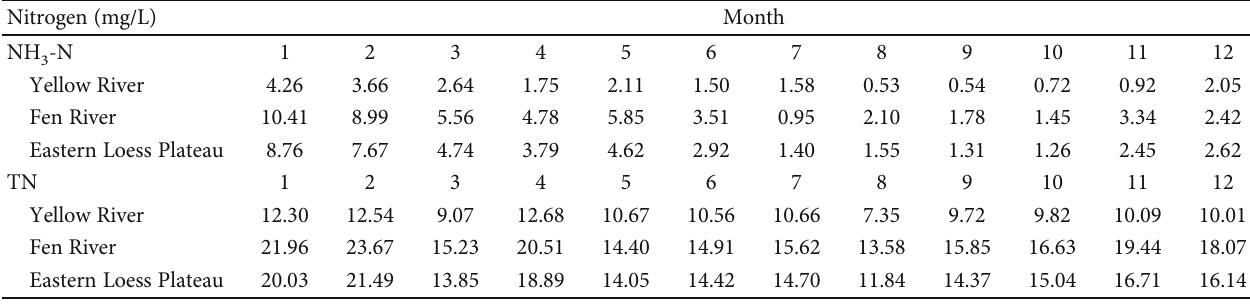
Table 3: The variations of the nitrogen concentrations in Yellow River and Fen River Basins during January to December in 2019. Nitrogen (mg/L)